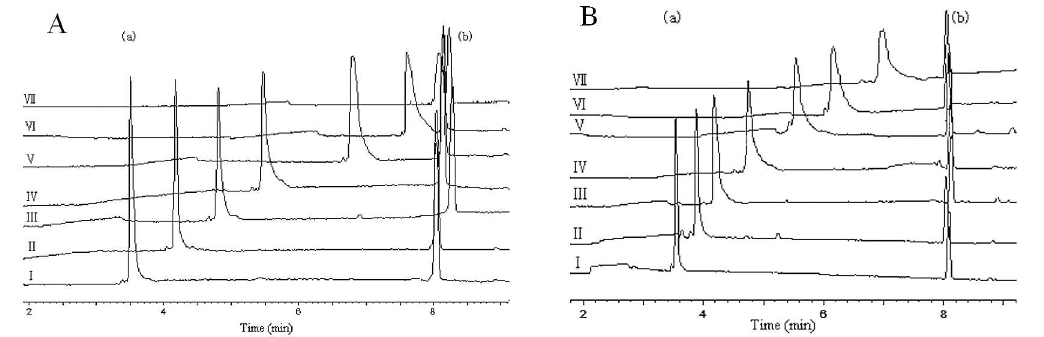
Fig 1. Electropherograms of Apep10 and acetone in the runningbuffer with various concentrations of (A) the E . coli membrane lipid liposome and (B) the mixed phospholipids liposomeat 303 K. The liposomeconcentrations (mg/ml) were: Ⅰ , 0; Ⅱ , 0.1; Ⅲ , 0.2; Ⅳ , 0.4; Ⅴ , 0.8; Ⅵ , 1.2; Ⅶ , 1.6. The electrophoresis conditions used were as follows: injection, 0.8 psi for 6 s; separationvoltage, 25 kV; detection, UV detection at 196 nm; and capillary,65 cm × 75 μ m inner diameter. Peaks (a) and (b) were Apep10 and acetone,